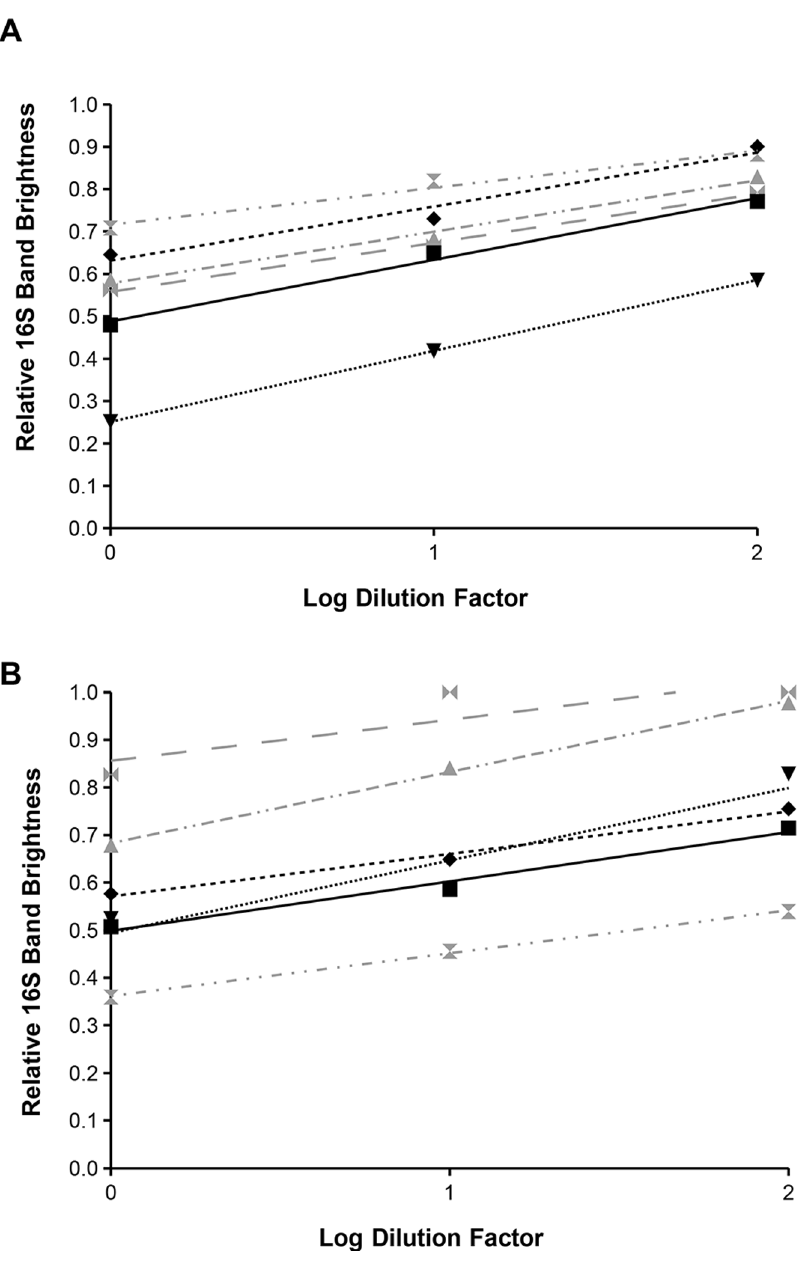
Figure 7. Assay Dilution Series. The dilution series shows a linear relationship between template concentration and relative 16S band brightness for gDNA (A) and cDNA (B). Relative 16S band brightness is plotted against log 10 dilution factor. Symbol shape and line style correspond to nucleic acid samples from individual cultures. Grey symbols and lines indicate S. diplocostata , black symbols and lines indicate D. grandis . Trend lines fitted by regression analysis found an average slope of 0.12 6 0.01 across all samples. Trend lines in all cases had r 2 . 0.9, with the exception of one dilution set which showed saturation (relative 16S band brightness=1) after 10-fold dilution (in this case r 2 =0.75).